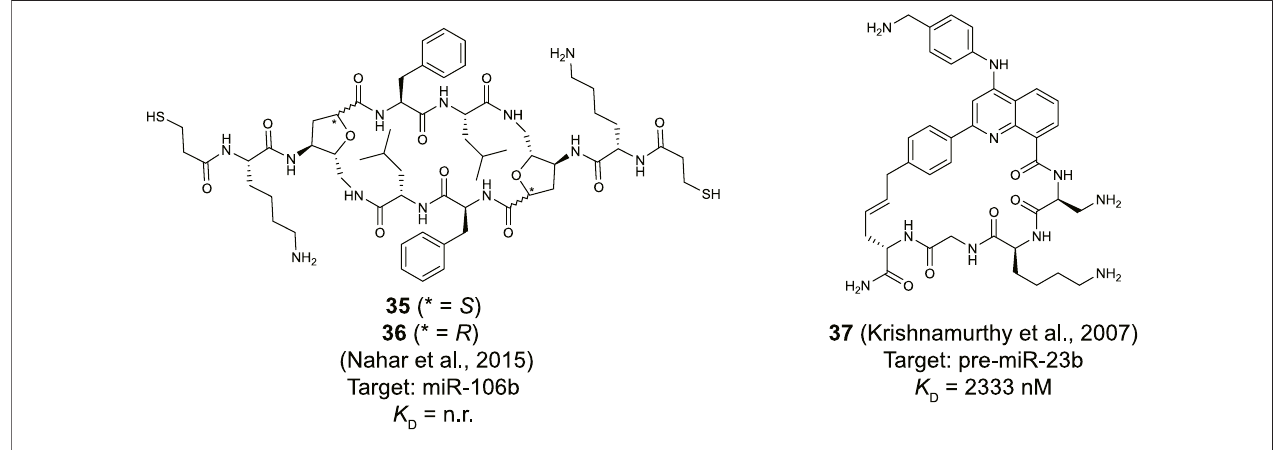
FIGURE 14 | Structures of natural product derived cyclic peptides targeting RNA. n. r. = not